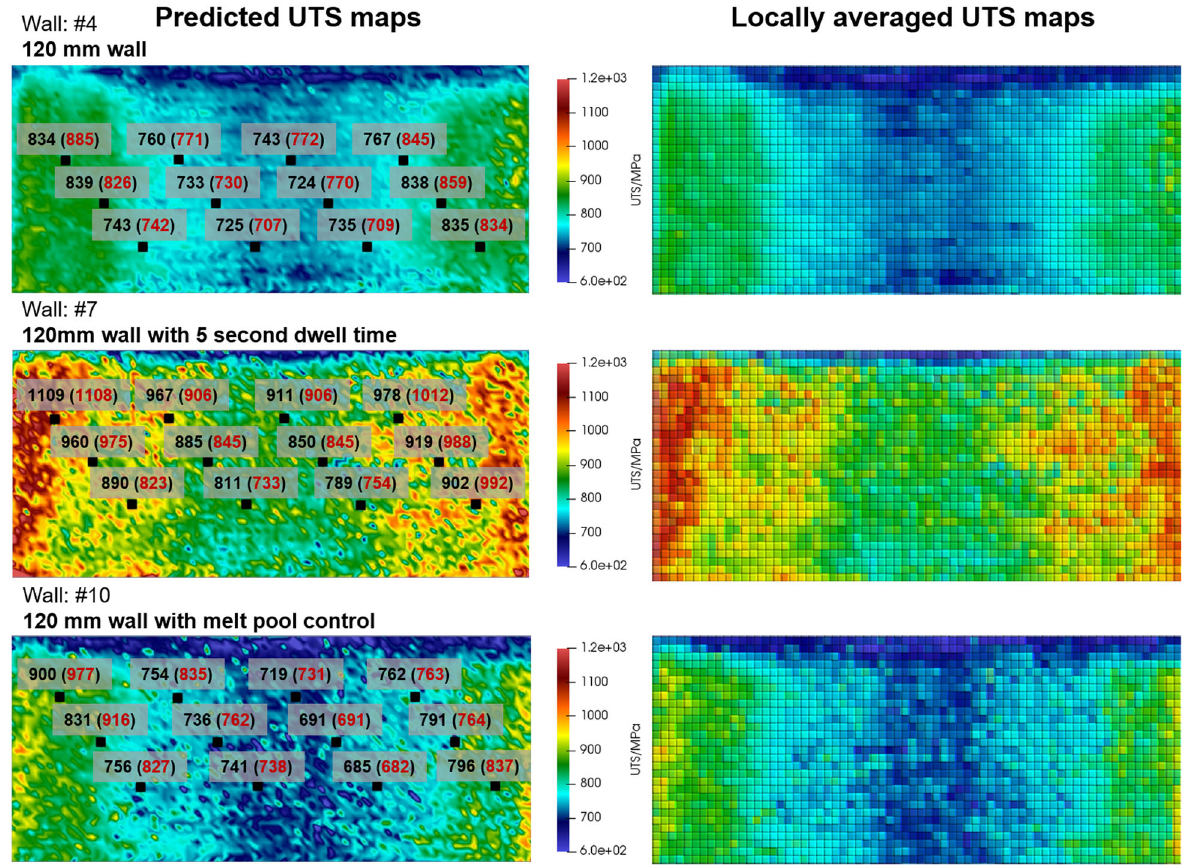
Fig. 2 Predicted UTS maps for three process conditions. The process conditions include 120 mm wall without any dwell time and melt pool control, 120 mm wall with 5 s dwell time, and 120 mm wall with melt pool control. The CNN outputs (in black) and experimental values (in red) are marked as